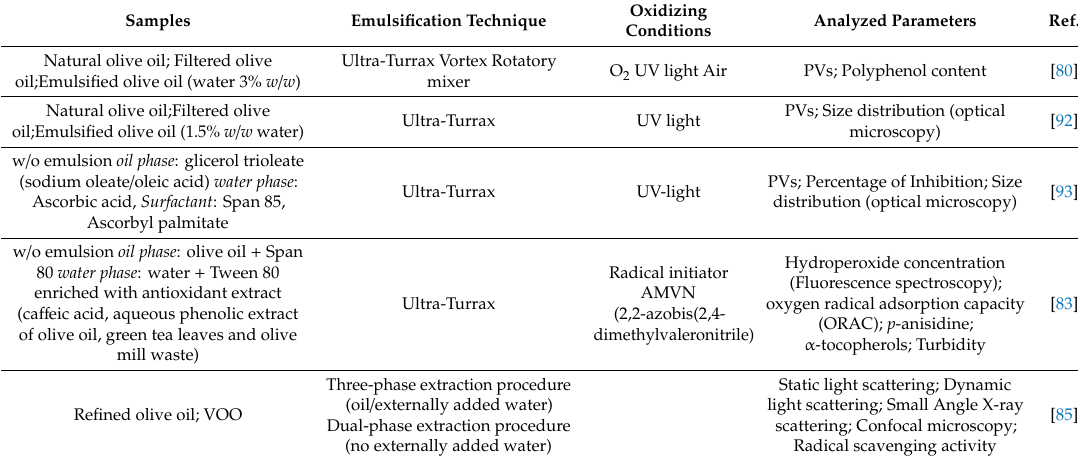
Table 1. Examples of oxidation and kinetics stability of W / O